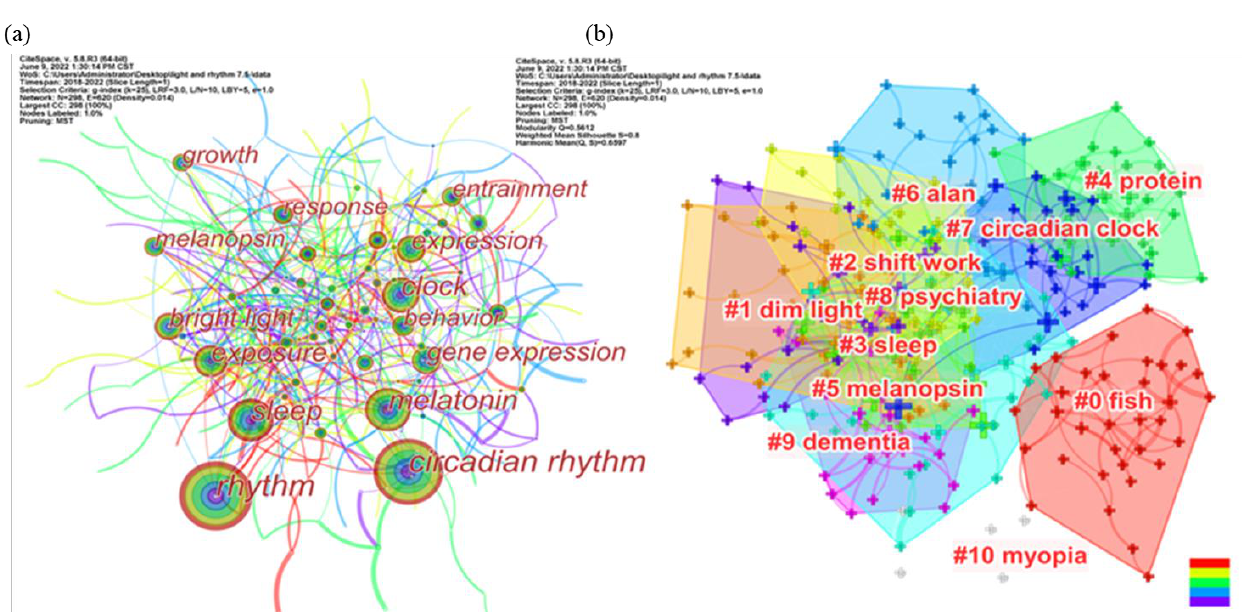
Figure 3. Keyword co-occurrence ( a ) and cluster ( b ) analysis. The number of nodes ( a ) indicates the wide research scope, and the annual rings of different colors on the nodes represent the keywords appearing in the articles of different years. The smaller the number of cluster tags ( b ), the more keywords they contain.